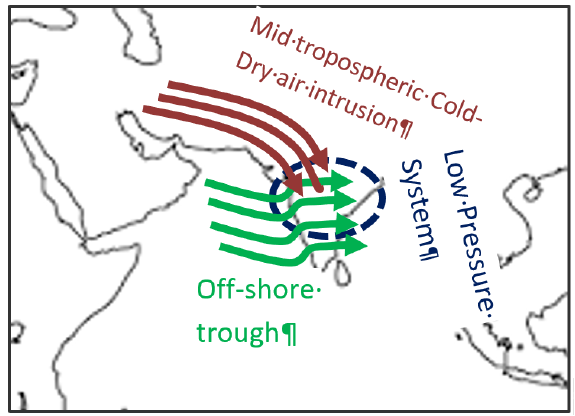
Figure 12. Interaction of the mid-tropospheric cold-dry air, off-shore trough, and low-pressure system over the Indian region during the Kerala Flood Event (KFE).